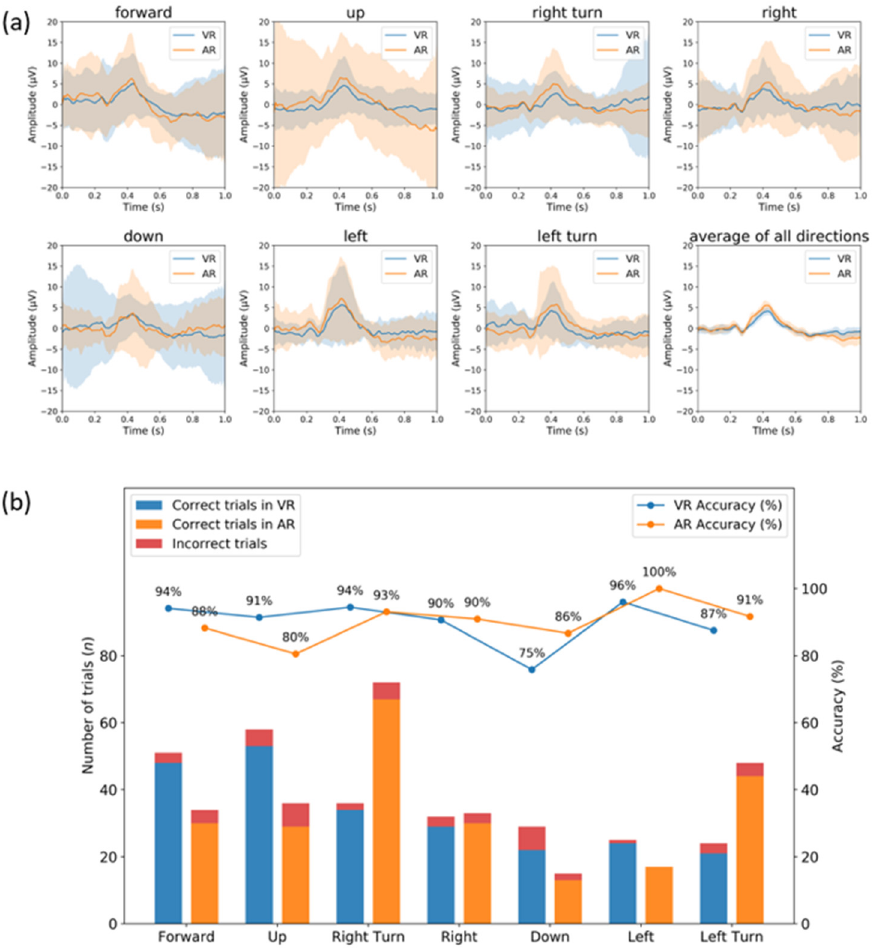
Figure 8. ( a ) ERP signal ( n = 17) averaged over seven directions (forward, up, down, right, right turn, left, and left turn) in VR (blue line) and AR (orange line) environments. Standard deviations are presented with areas. ( b ) All subjects’ direction-based